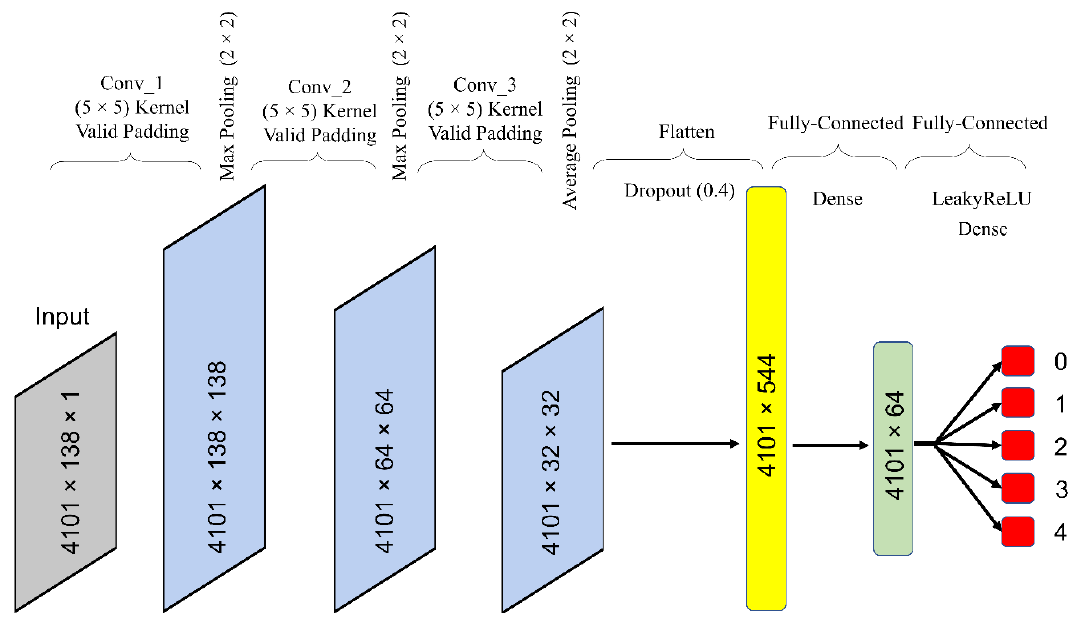
Figure 1 . The proposed CNN architecture proposed in this